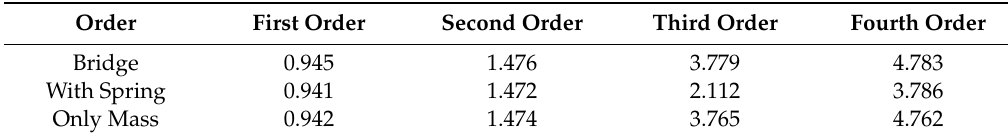
Figure 9. Relative displacement x c ( t ) between the vehicle and the bridge.